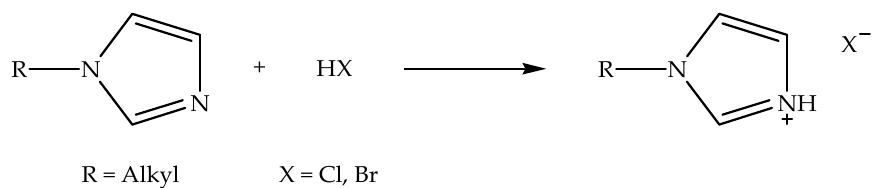
Figure 1. Schematic of the protonation reaction of N -alkylimidazole with hydrohalic acid to prepare alkylimidazolium halide ionic liquid.